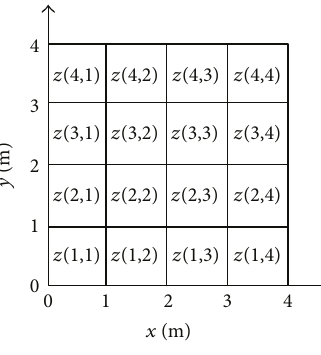
Figure 2: The storage format of the DEM